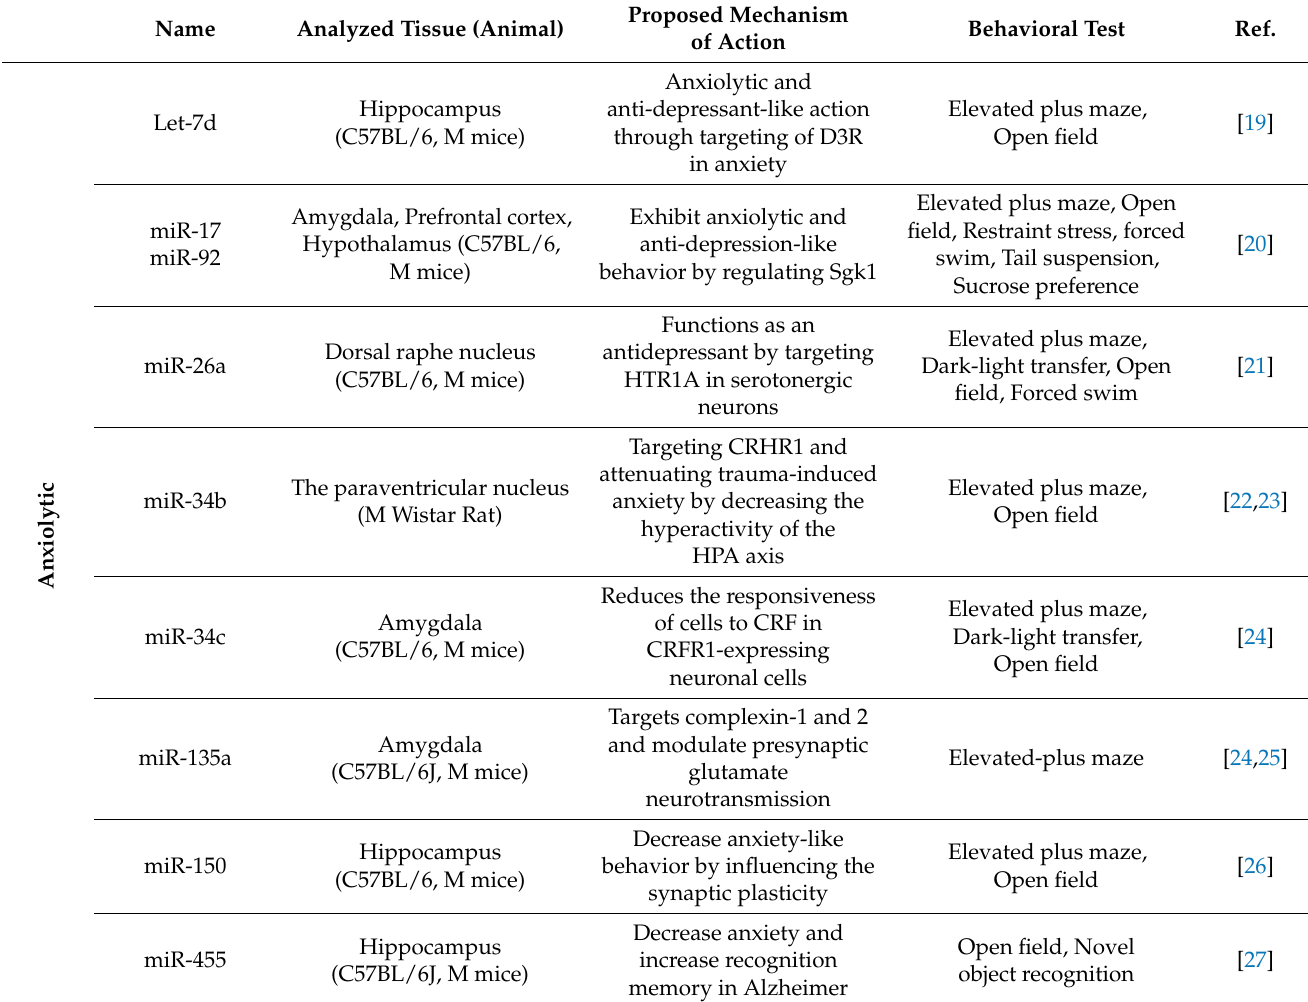
Table 1. List of anxiolytic (9), anxiogenic (10), and other anxiety-related